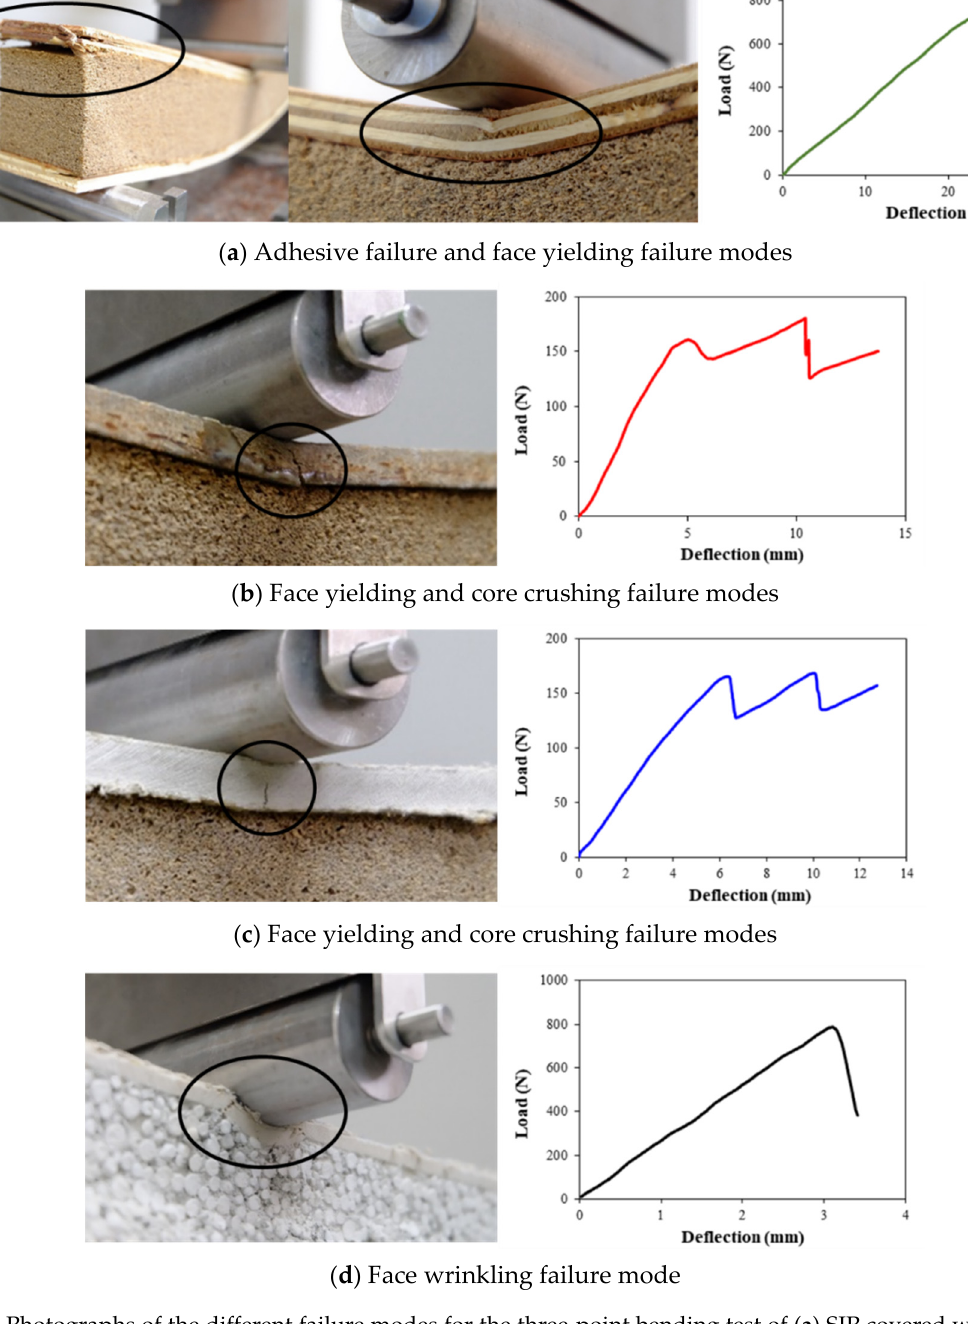
Figure 12. Photographs of the different failure modes for the three-point bending test of ( a ) SIP covered with plywood, ( b ) SIP covered with cement particleboard, ( c ) SIP covered with fiber-cement board, and ( d ) EPSCSW along with their corresponding representative load-deflection curves.